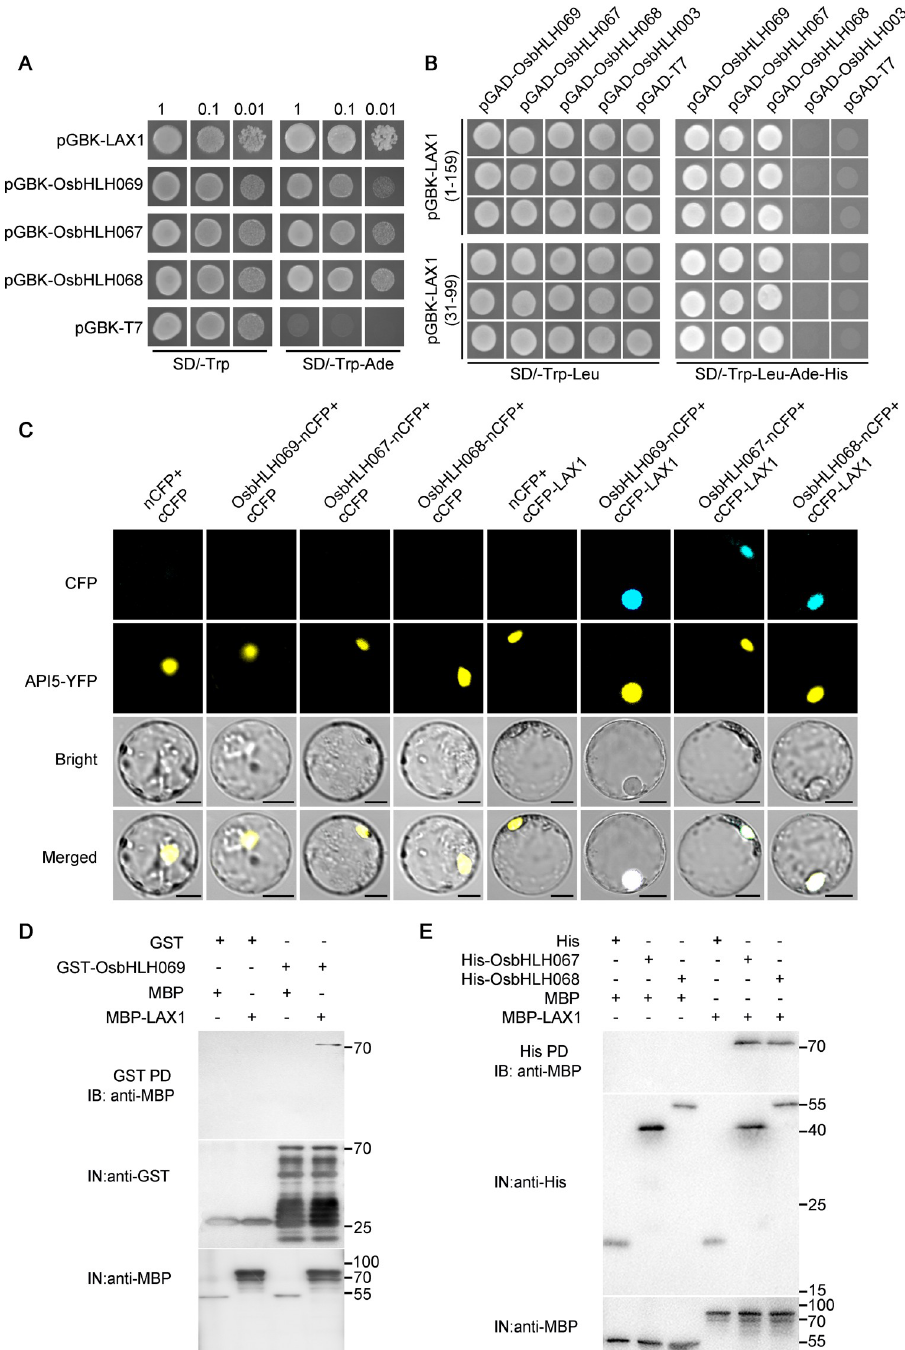
Fig 7. Molecular interactions between OsbHLH067/068/069 and LAX1. (A) Transcription activity assay of OsbHLH067, OsbHLH068, OsbHLH069, and LAX1 in yeast cells. The coding sequences (CDS) of LAX1 , OsbHLH067 , OsbHLH068 , and OsbHLH069 were introduced into the pGBK-T7 vector, respectively. The empty vector pGBK-T7 served as a negative control. Both vectors were transformed into AH109, respectively. Cultures were diluted (1:10 successive dilution series) and spotted onto the control medium without Trp and selective medium without Trp and Ade. (B) In yeast two-hybrid assays, OsbHLH067/068/069 interacts with LAX1 through the bHLH domain of LAX1. The pGBK-LAX1(1–159)/pGBK-LAX1(31–99) and pGAD-OsbHLH003 combinations were separately used as negative controls. (C) Bimolecular fluorescence complementation (BiFC) analysis shows the interaction between OsbHLH067/068/069 and LAX1 in rice protoplasts. API5-YFP served as a nuclear marker. Bars = 10 μ m. (D) and